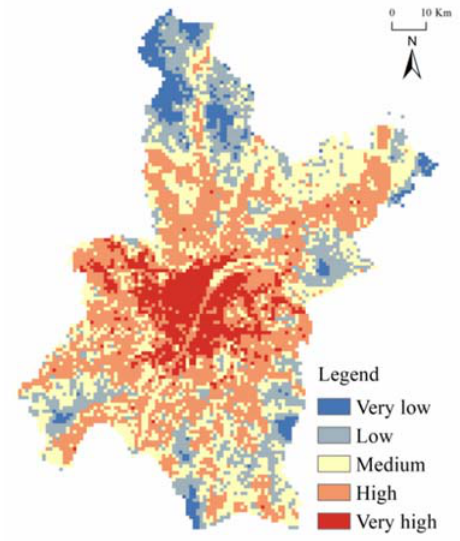
Figure 7. Suitability levels of urban expansion.